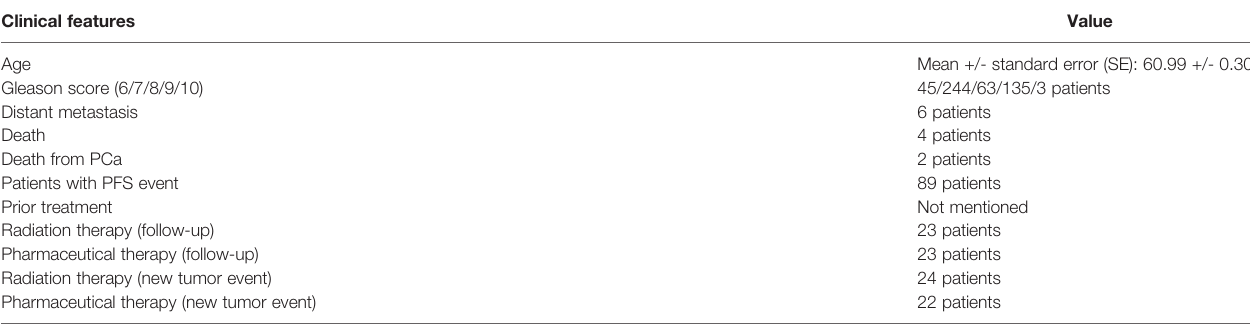
TABLE 1 | Clinical features for 490 PCa patients from the TCGA cohort. Clinical